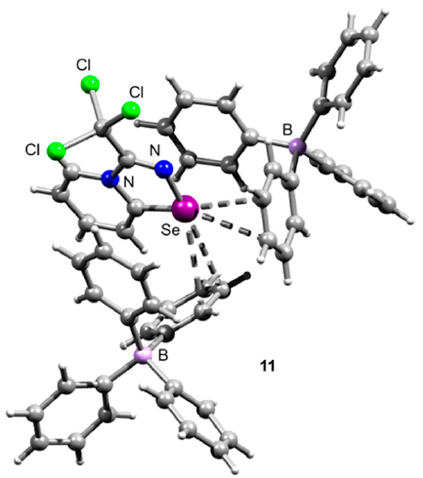
Figure 7. Ball-and-stick representation of the crystal structure of 11 demonstrating ChB interactions between the selenodiazolium and two neighboring tetraphenylborates. Grey and light-grey spheres represent carbon and hydrogen, respectively.